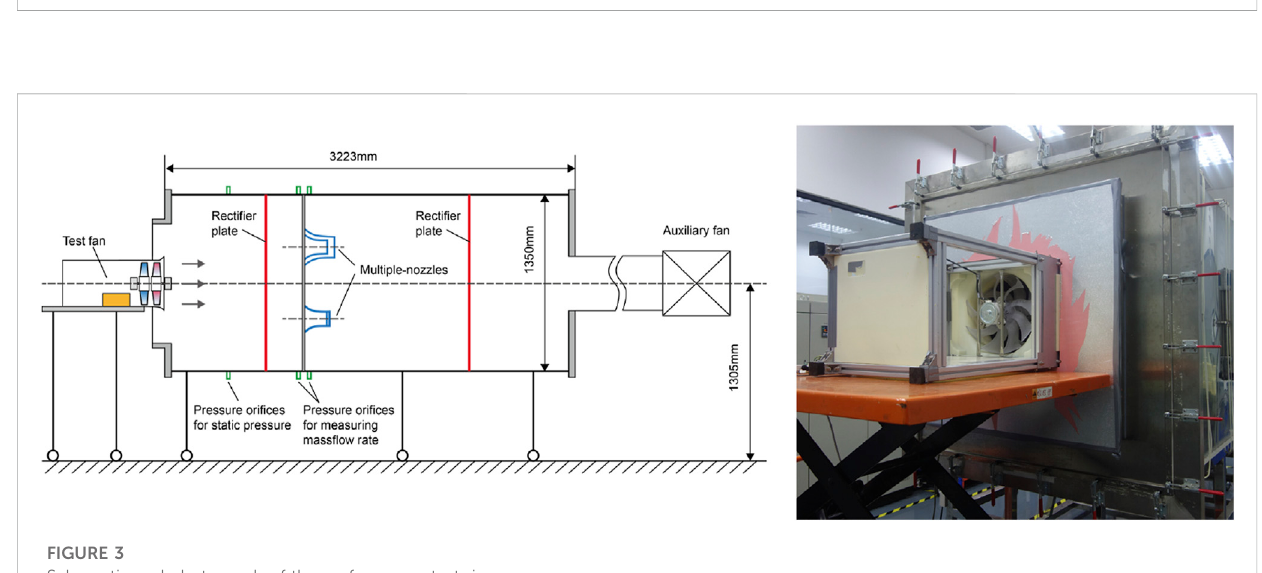
FIGURE 2 Distribution of blade pattern and blade thickness: (A) blade pattern; (B) blade thickness.